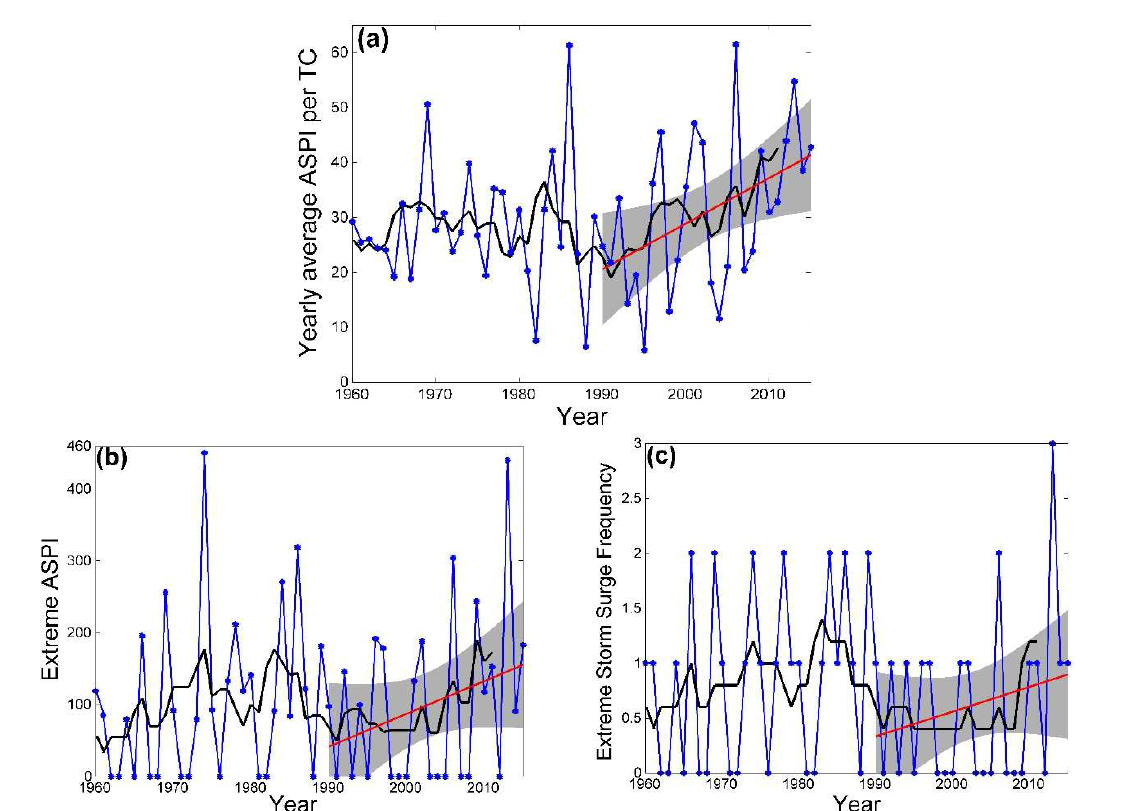
Figure 3. Time series of ( a ) yearly average ASPI per TC, ( b ) annual-summation extreme ASPI, ( c ) annual frequency of extreme ASPI along southeastern coastline of China from 1960 to 2015. Thick lines are the 5-year running average with the red line schematically indicating trends. Shading shows 95% confidence bounds .